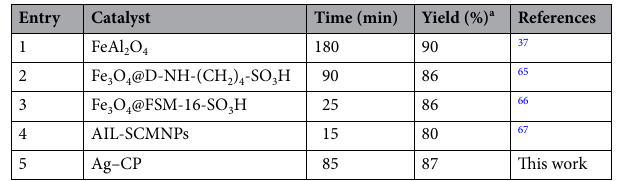
Table 3. Comparison of the synthesis of polyhydroquinolines in the presence of various catalysts. a Isolated